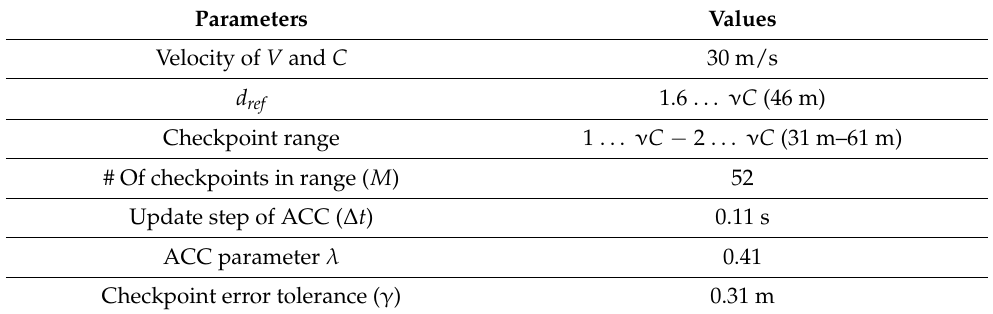
Table 1. Simulation